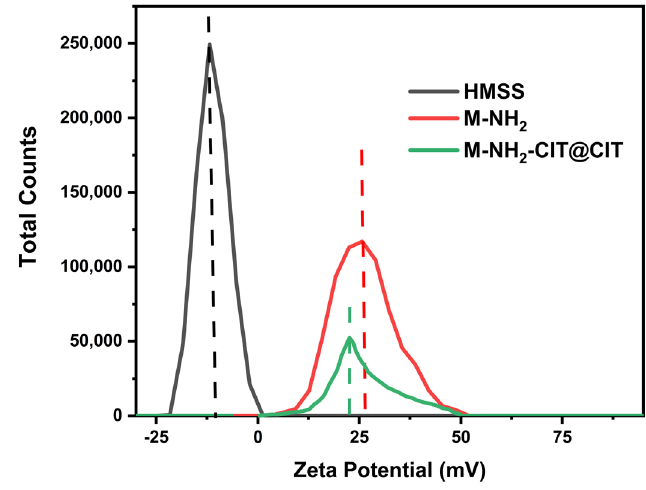
Figure 1. Zeta distribution curve of HMSS, M-NH 2 , and M-NH 2 -CIT@CIT. The SEM image in Figure 2 reveals the difference in size and morphology between HMSS and M-NH 2 -CIT@CIT. As shown in Table 1, the average particle size of HMSS was 616 nm, while the average particle sizes of functionalized M-CIT and M-NH 2 -CIT@CIT were 627 and 634 nm, respectively. All materials exhibit a desirable morphology and uniform particle size distribution, and their unique spherical hollow structure offers a high specific surface area while ensuring high CIT load. Some fine particles can be seen on the surface of HMSS after functionalization by CIT, which slightly increases its surface roughness. This discovery demonstrates that the synthesis of M-NH 2 -CIT@CIT does not affect the overall morphology and mesoporous structure of HMSS, indicating the high stability of hollow mesoporous silica spheres [31,32]. This finding is consistent with the literature [33].